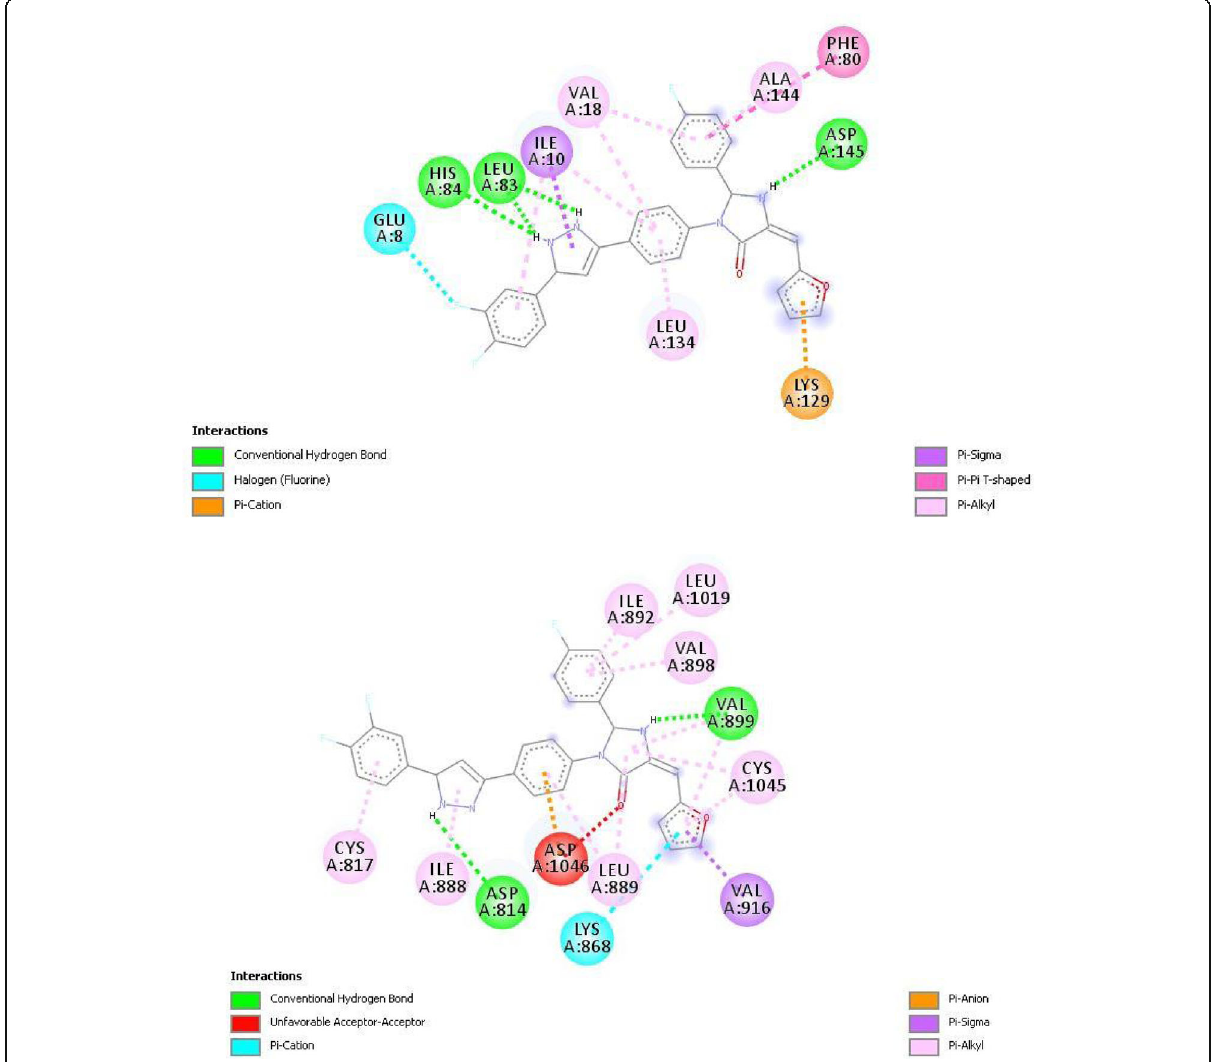
activity of test set compounds. Table S4 . Molecular descriptors and predicted cytotoxic activity of designed